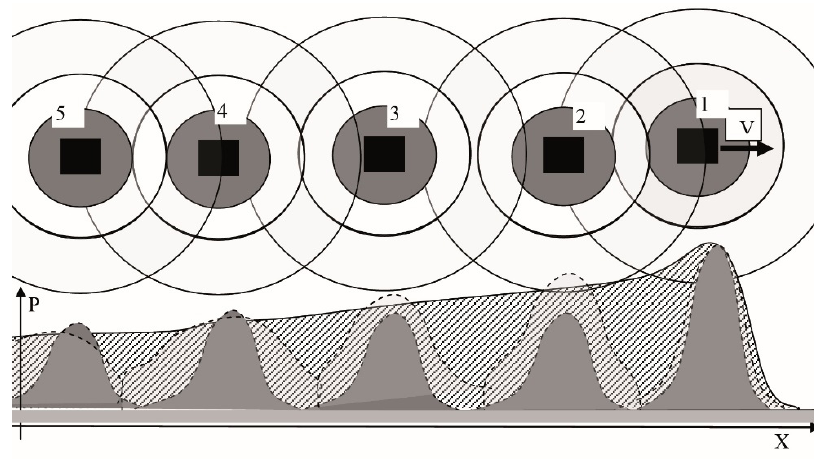
Figure 9. The probability of robots moving in a line.